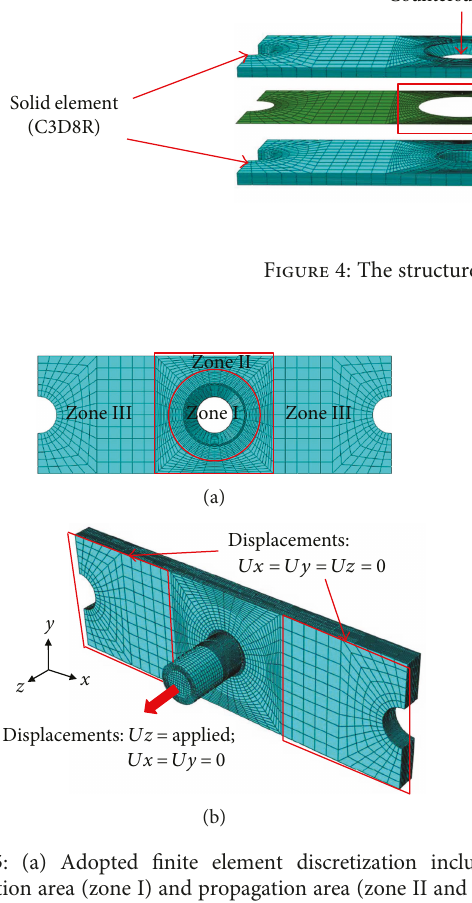
Figure 6: Load-displacement curves. Numerical predictions and experimental